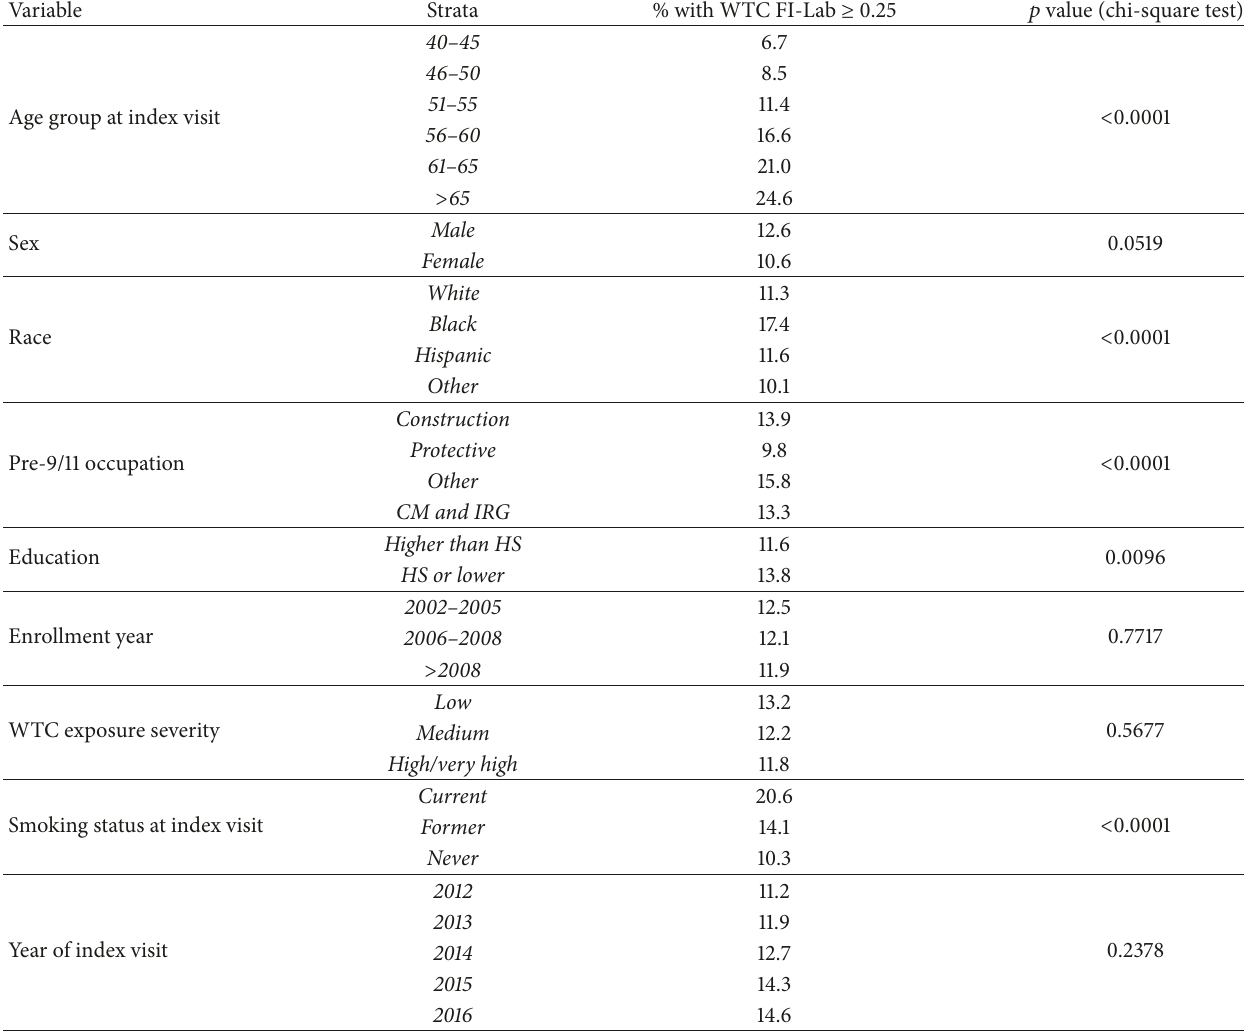
Table 6: Prevalence of frailty (stratified by demographic characteristics) within the study